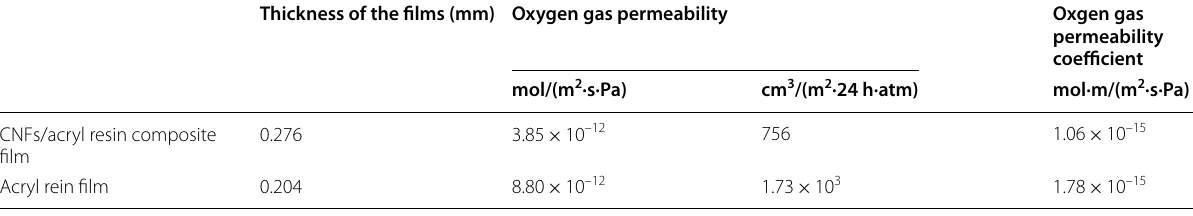
CNF content was 1.5 wt% Average of 3 independent measurements are